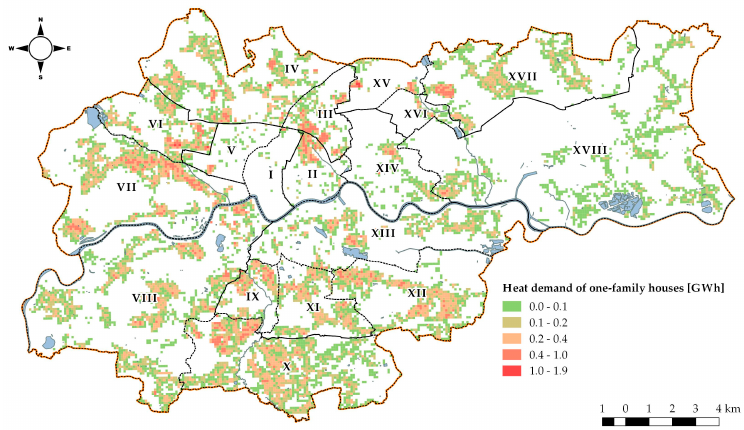
Figure 4. Annual total useful heat demand of one-family houses in GWh.